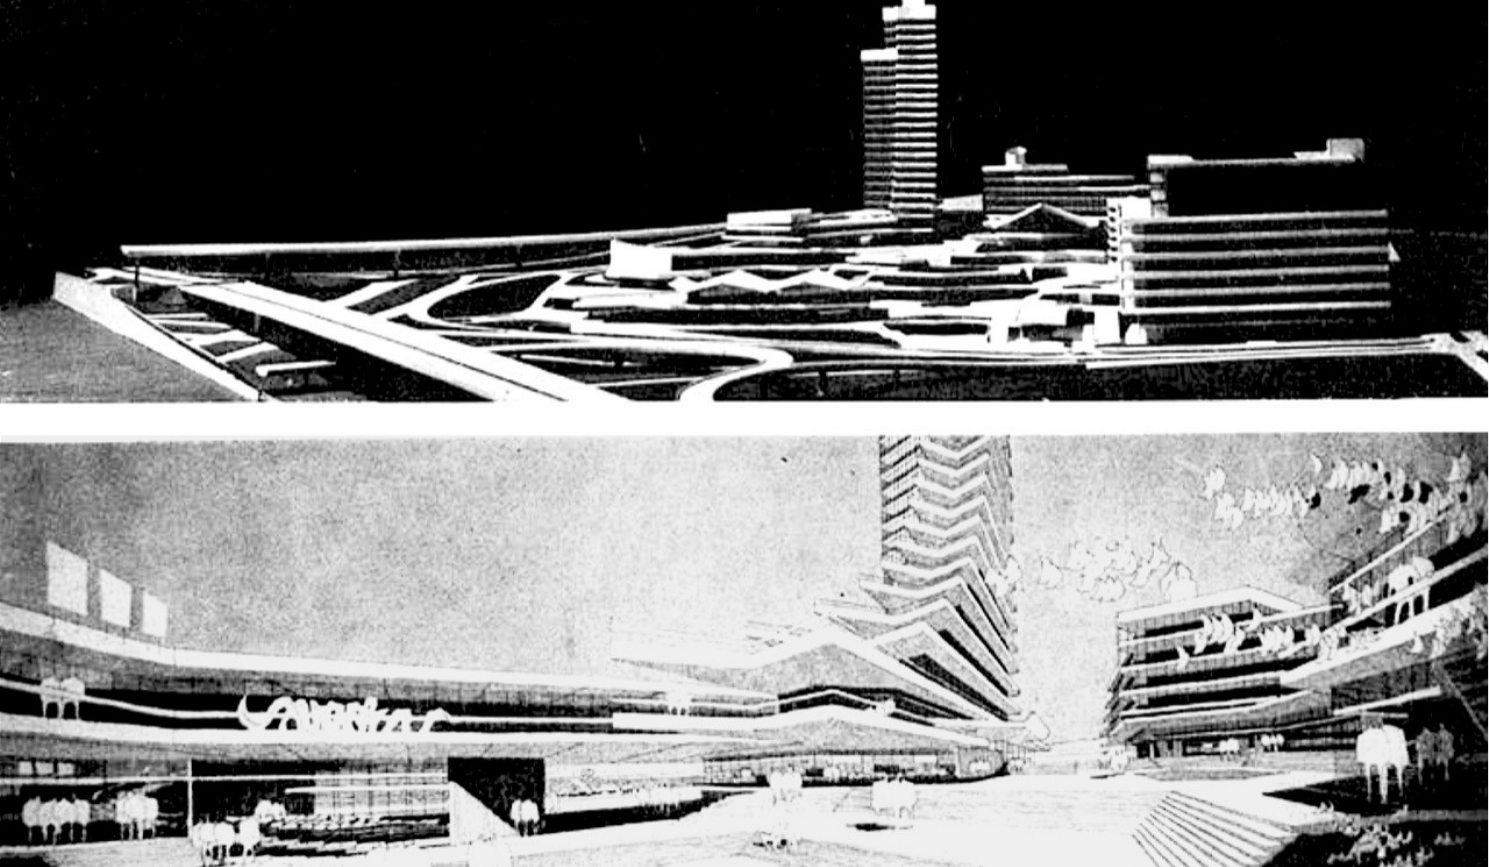
Fig. 6 Model and drawing by Jovin and Kaludjerić of the compe- tition entry for Mostar/s raion centre in Belgrade along the Highway (Source: Arhitek- tura Urbanizam, no.